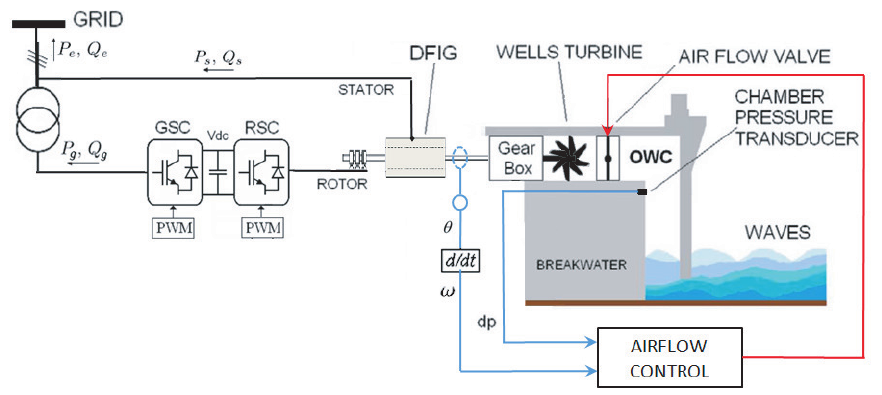
Figure 5. Airflow control scheme strategy for OWC plant equipped with Wells turbine [24].